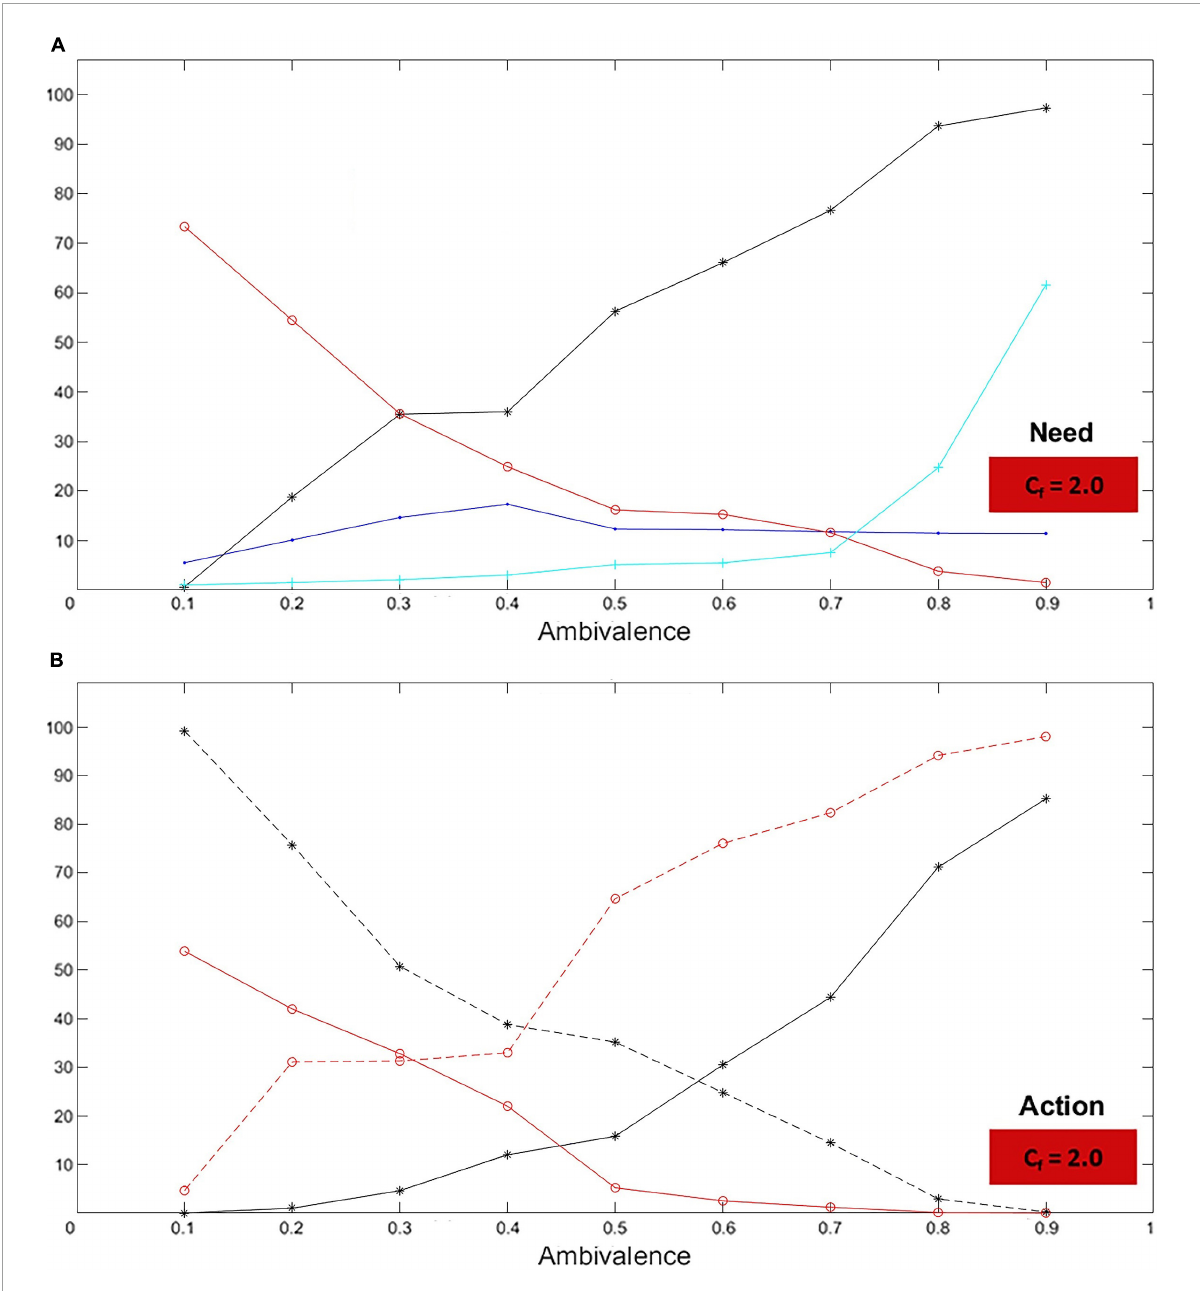
FIGURE12 Ambivalent case: Need and action. The graphs represent characteristics for the child (black curves) and the caregiver (red curves) for levels of ambivalence ( A m ) and unresponsiveness ( U n ) ranging between 0.1 and 0.9 (with step 0.1). The blue curve represents the distance measured in the lab between the child and the caregiver. The cyan curve represents the number of iterations without caregiving. In particular, as A m and U n increase, it is shown that: (A) The need for care (felt by the child) increases while the need to give care (felt by the caregiver) decreases. (B) The child increases their approaches and decreases their exploration (dashed curve), while the caregiver increases their exploration (dashed curve) and decreases their approaches. All these phenomena are entirely consistent with what attachment studies describe.